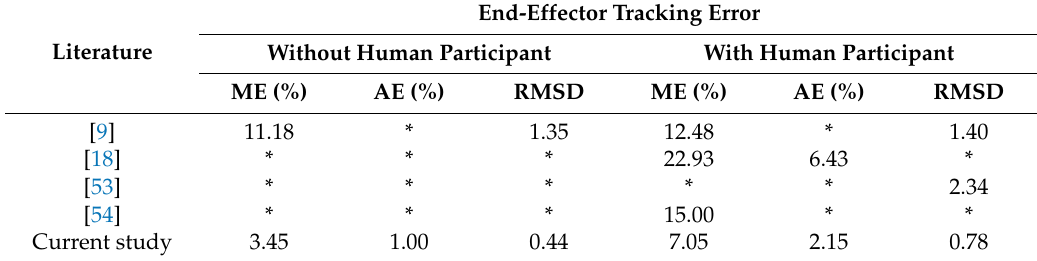
Table 7. Comparison of existing control methods and the proposed method for PMs-driven parallel rehabilitation robot. (*,